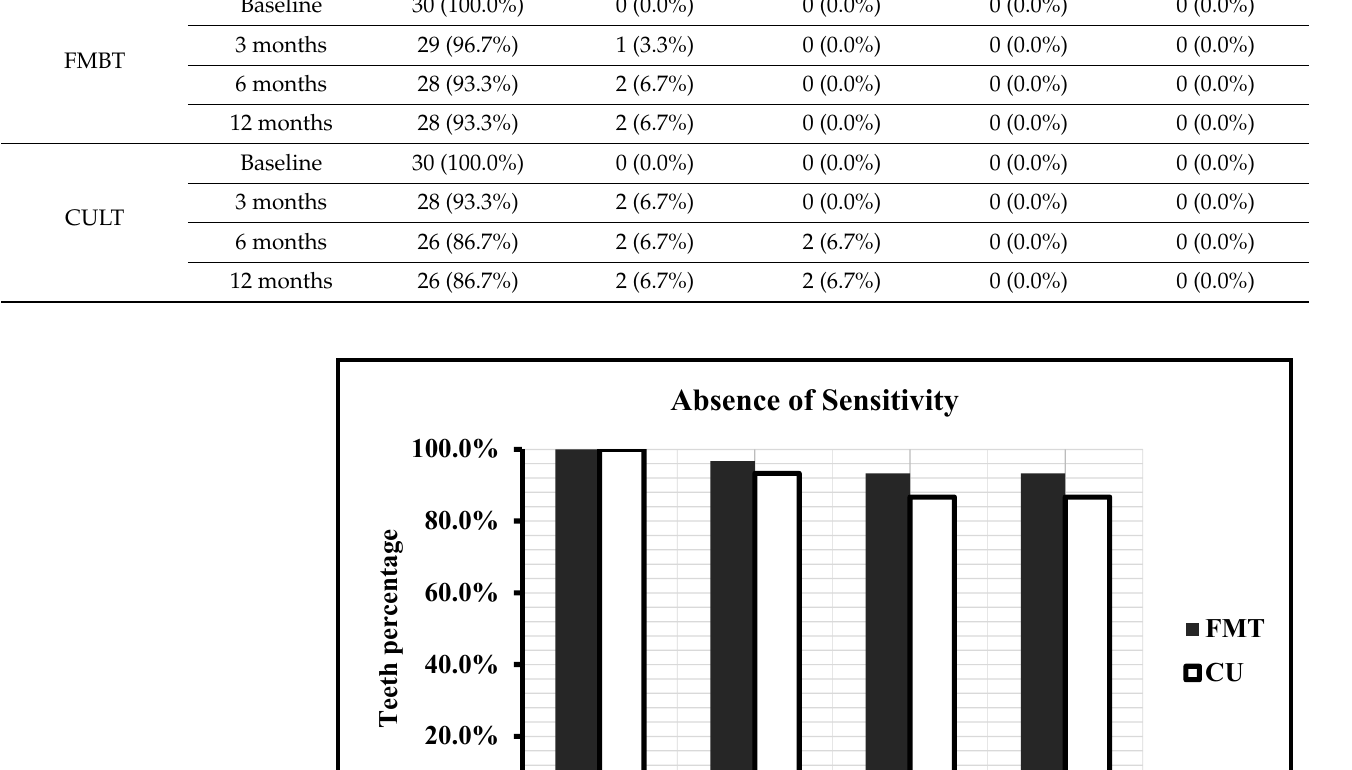
Table 4. Assessment of secondary caries for teeth restored with FMBT and CULT over time ( p > 0.05).